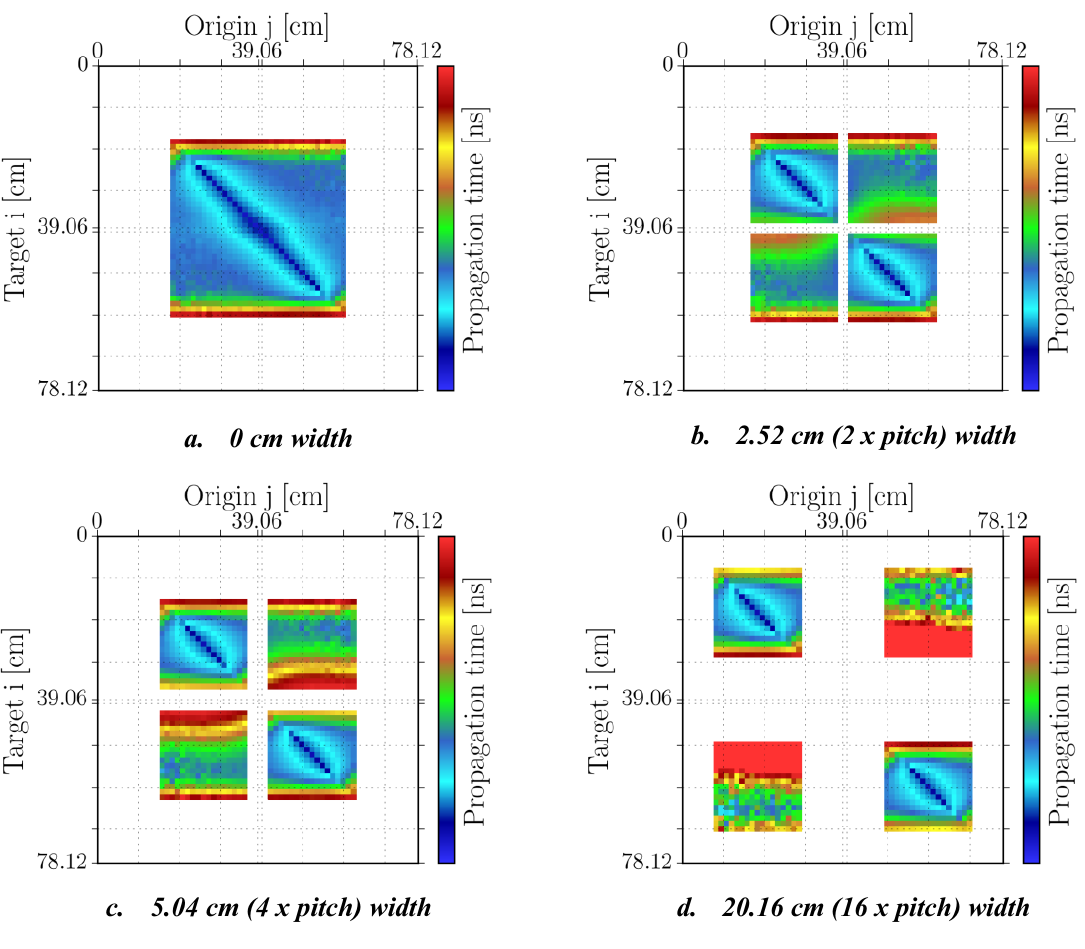
Figure 4. R N matrices for the UOX – UOX geometry, for different water blade widths. The color O P O scale expresses the propagation time and goes from 20 μs to 80 μs.